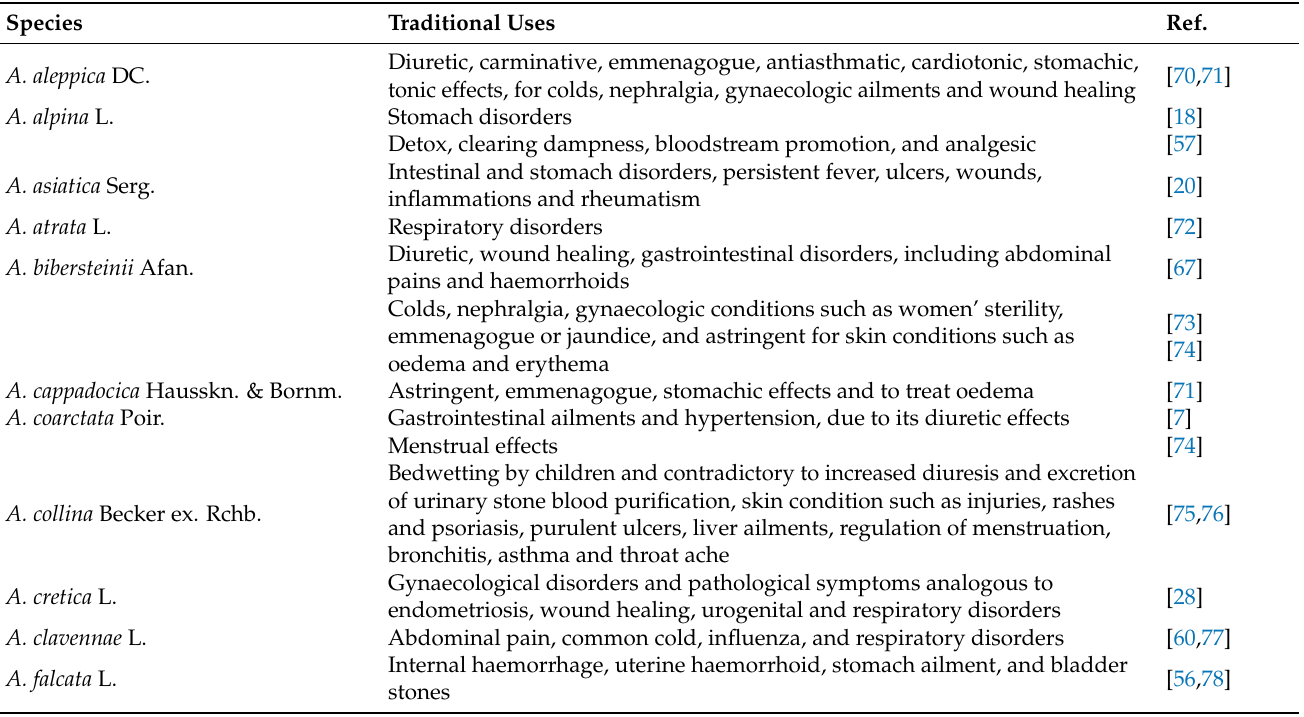
Table 14. Traditional medicinal uses of Achillea